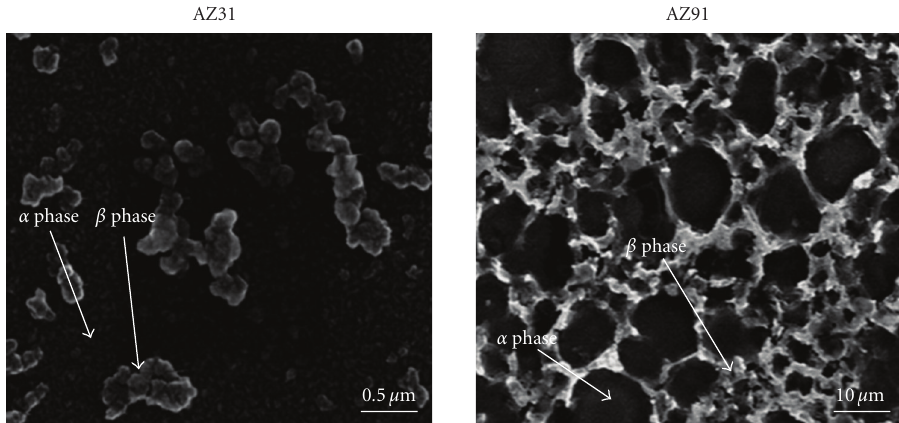
Figure 1: Surface morphologies of AZ31 and AZ91 magnesium alloys.